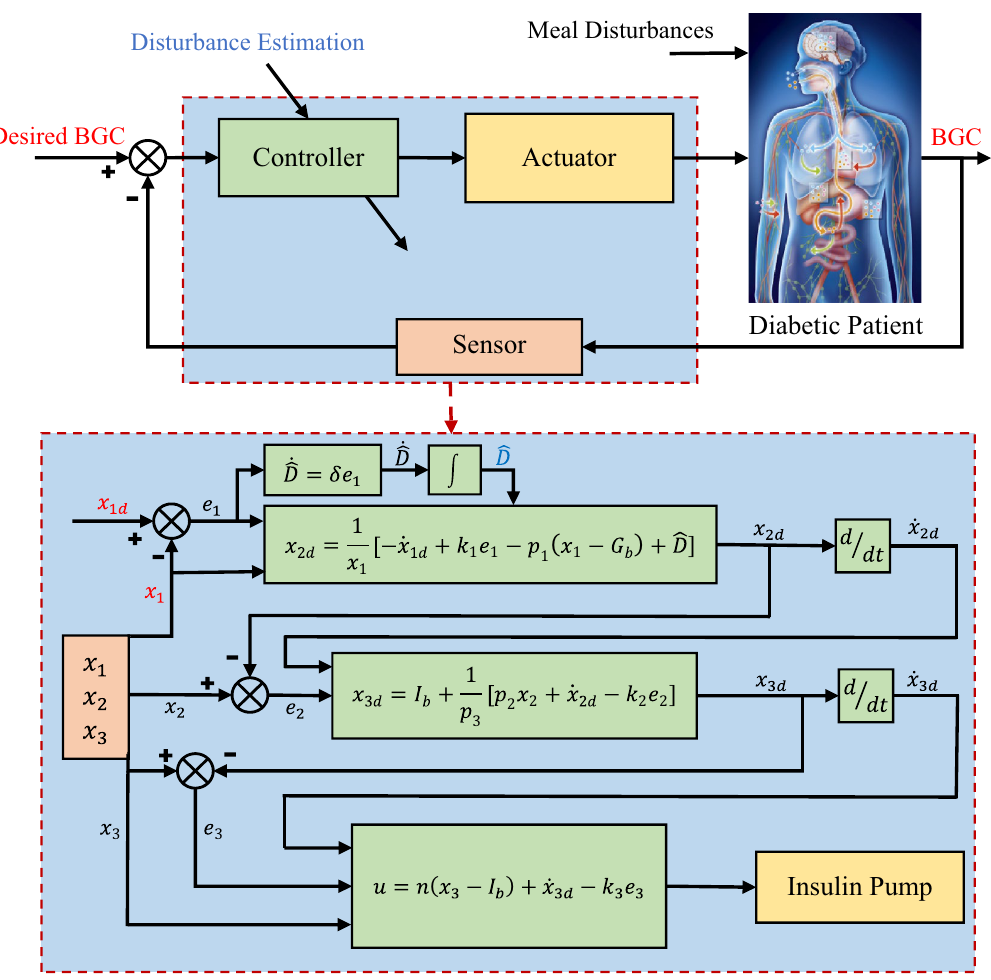
Figure 2. Block diagram of the adaptive backstepping algorithm proposed for the regulation of blood glucose for type-1